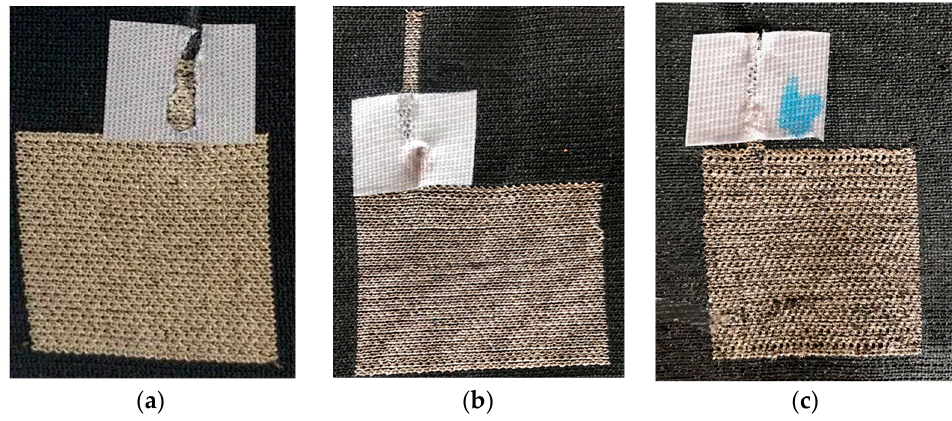
Figure 6. Photos from the samples: Unwashed ( a ), 15 timeswashed ( b ), 30 times washed ( c ).